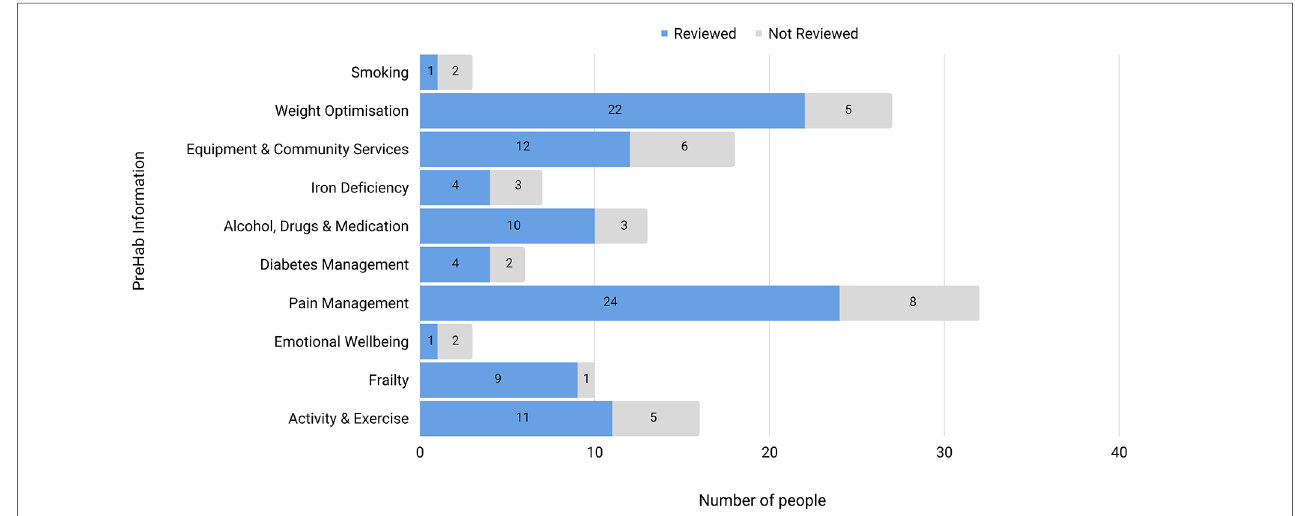
FIGURE 6 Prehab areas identi fi ed and the number of people who reviewed the information on each